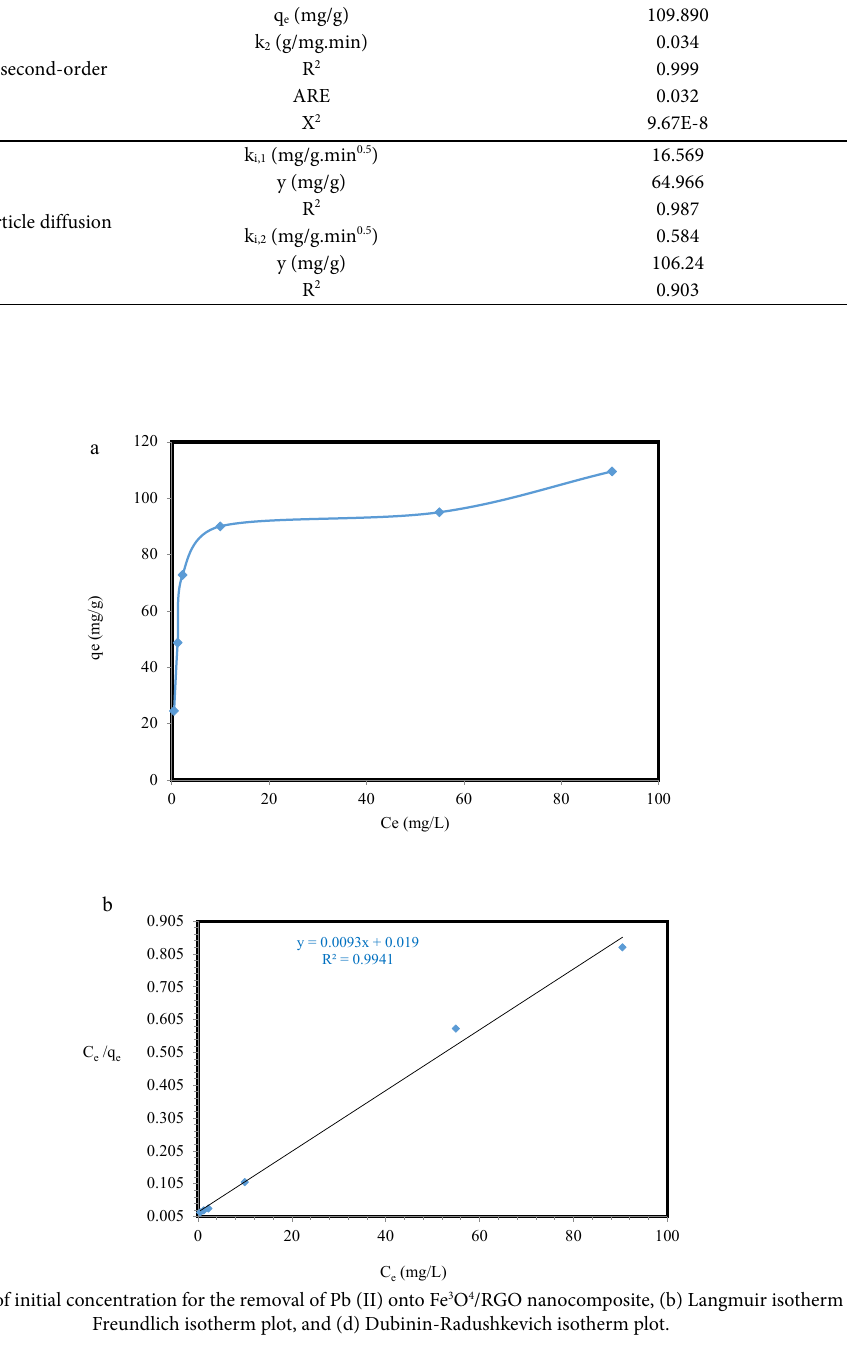
Table 1. Kinetic parameters for Pb (II) adsorption onto Fe